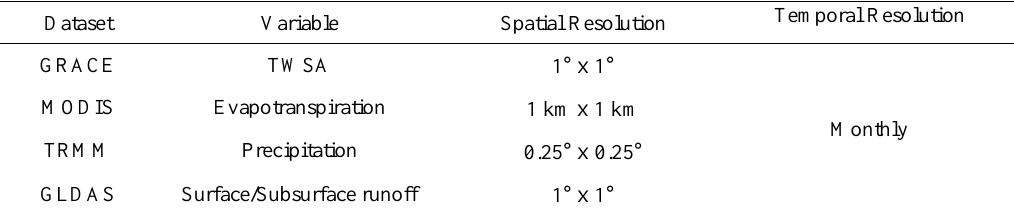
Table 1 Summary of datasets used for this